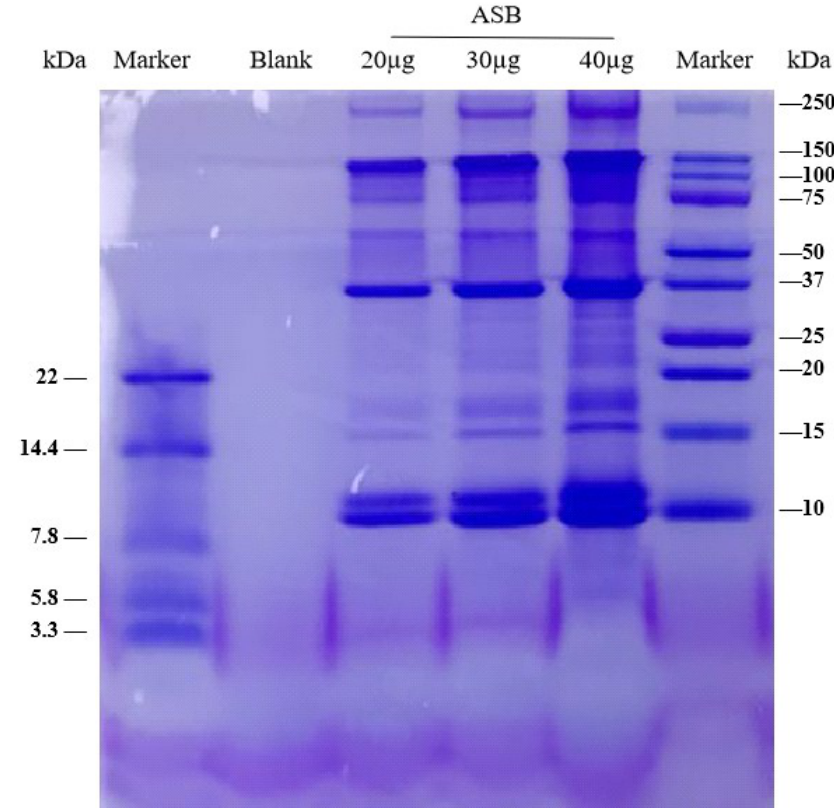
Figure 1. SDS-PAGE images of the aqueous extract of sea bass Figure 1. SDS‐PAGE images of the aqueous extract of sea bass (ASB).